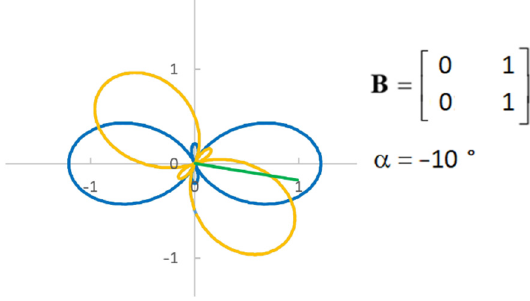
Figure 9. General tensor with 𝛼 = −10° .